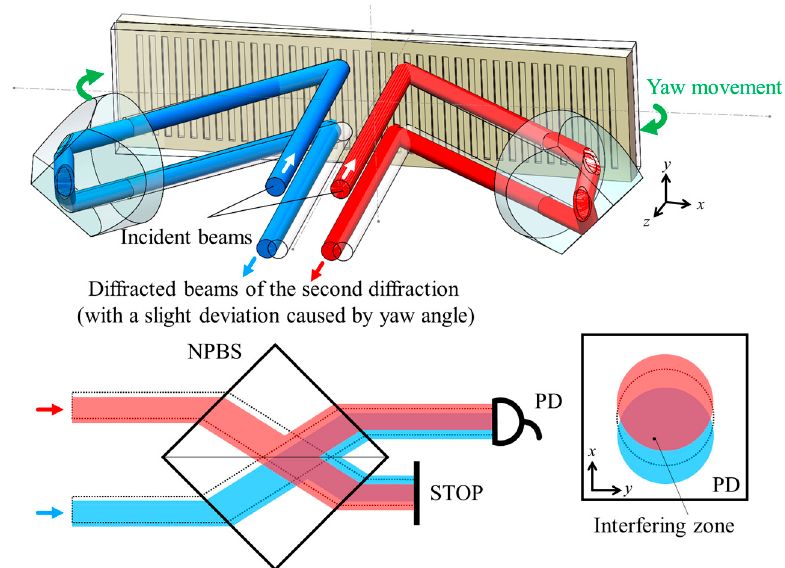
Figure 4. Geometrical analysis of the yaw movement and its influence on the measurement beam caused by spots deviation. (To be clear, the angles in the figure and their influence are exaggerated. Generally, these angles are no larger than several mrads or hundreds of arcseconds in actuality).